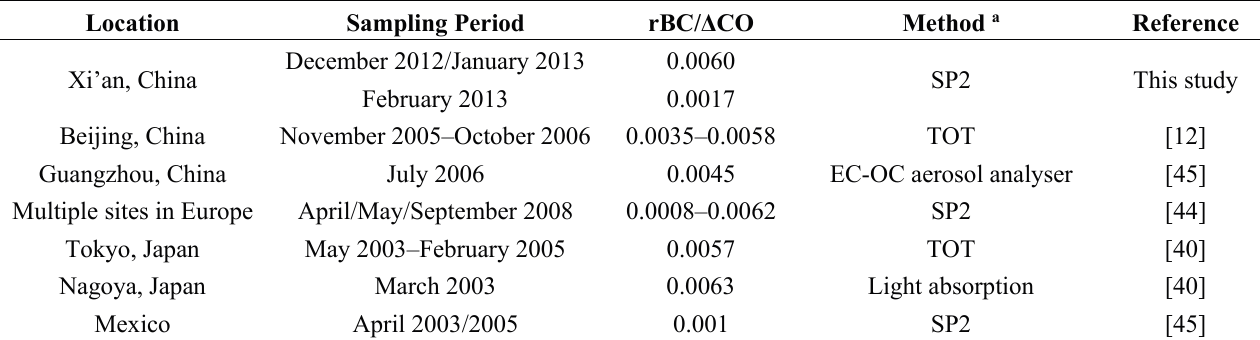
Table 2. Comparison of rBC concentrations to background-corrected CO mixing ratios (rBC/ Δ CO) in Xi’an with other